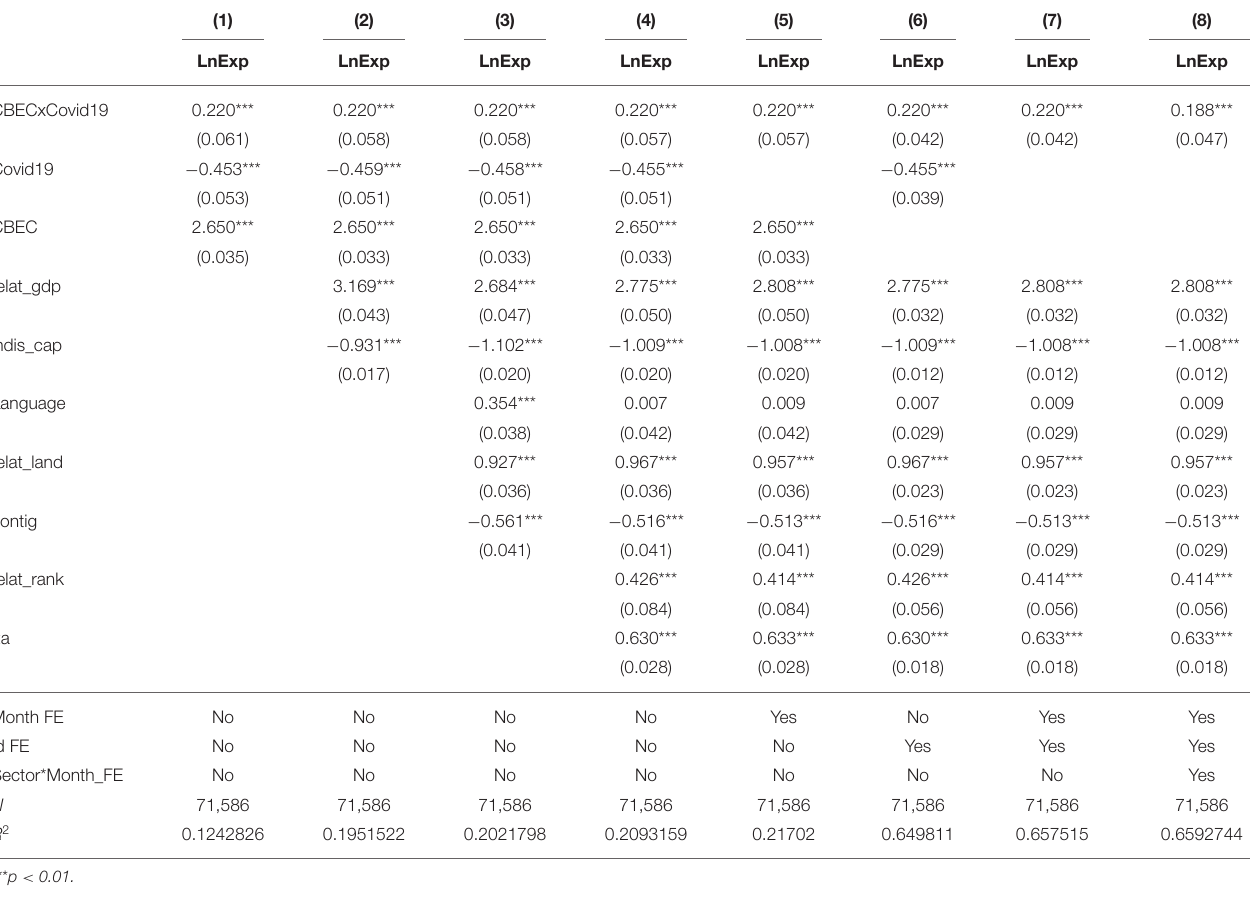
TABLE 2 | Baseline regression results.